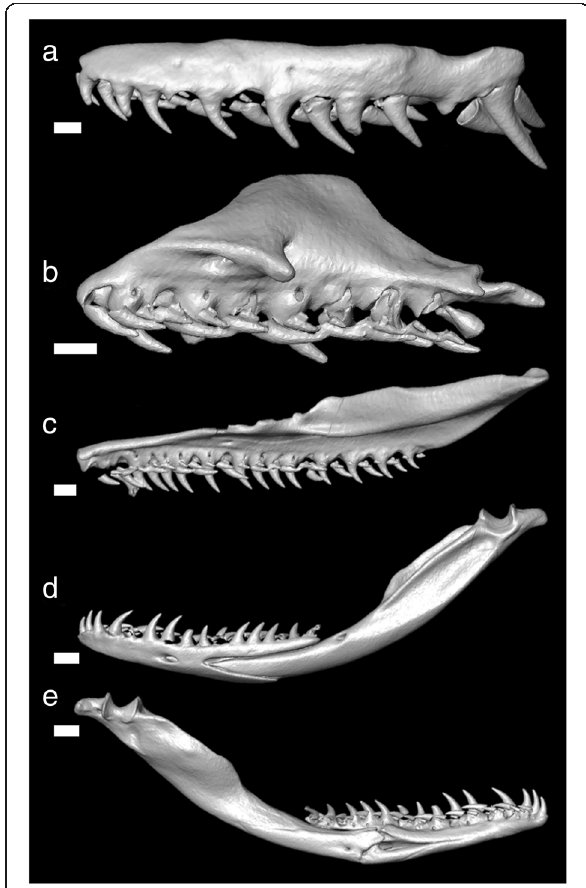
Fig. 2 Dentition of Leioheterodon madagascariensis (ZSM 806/2001) based on microcomputed tomography scans of the skull. Outer lateral views of: ( a ) maxilla, ( b ) palatine, ( c ) pterygoid, ( d ) mandible (outer lateral view); ( e ) inner lateral view of mandible. Scale bars = 1 mm for ( a – c ). Scale bars = 2 mm for ( d ) and ( e